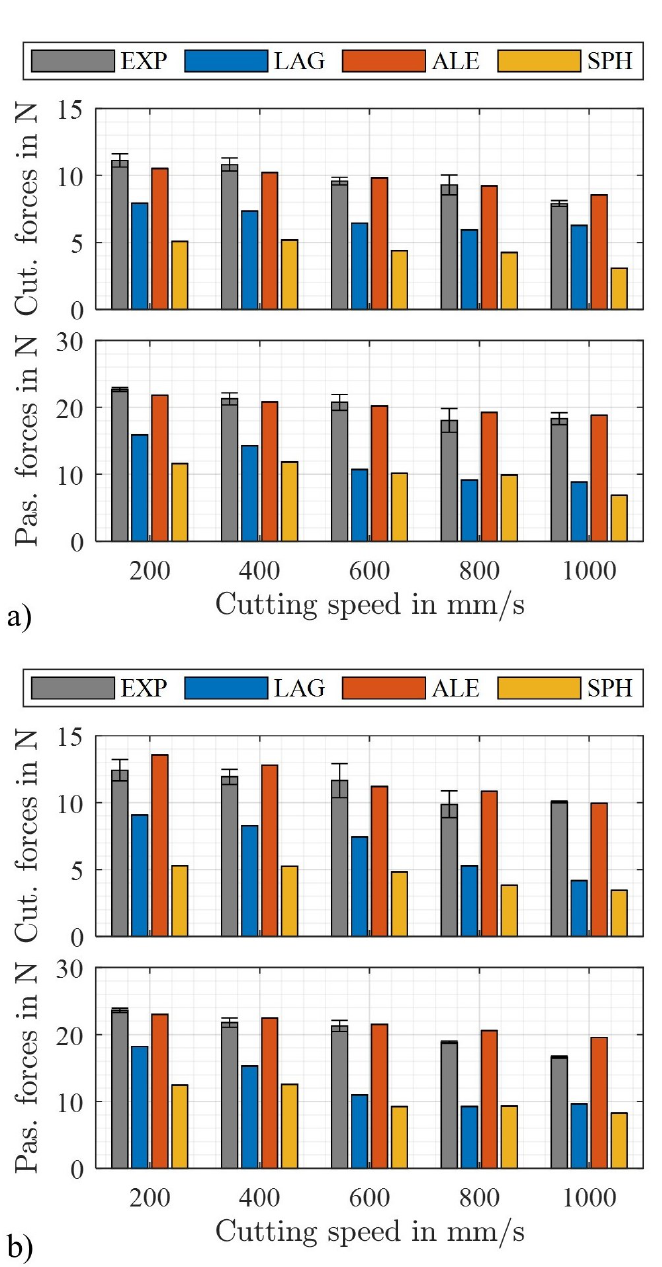
Figure 14. Process forces of measurement and discretization approaches for a 3D single grit scratch for a depth of cut a p = 50 µm that corresponds to a p ,sim = 30 µm with a cone angle of 105 ◦ ( a ) and with a cone angle of 120 ◦ ( b